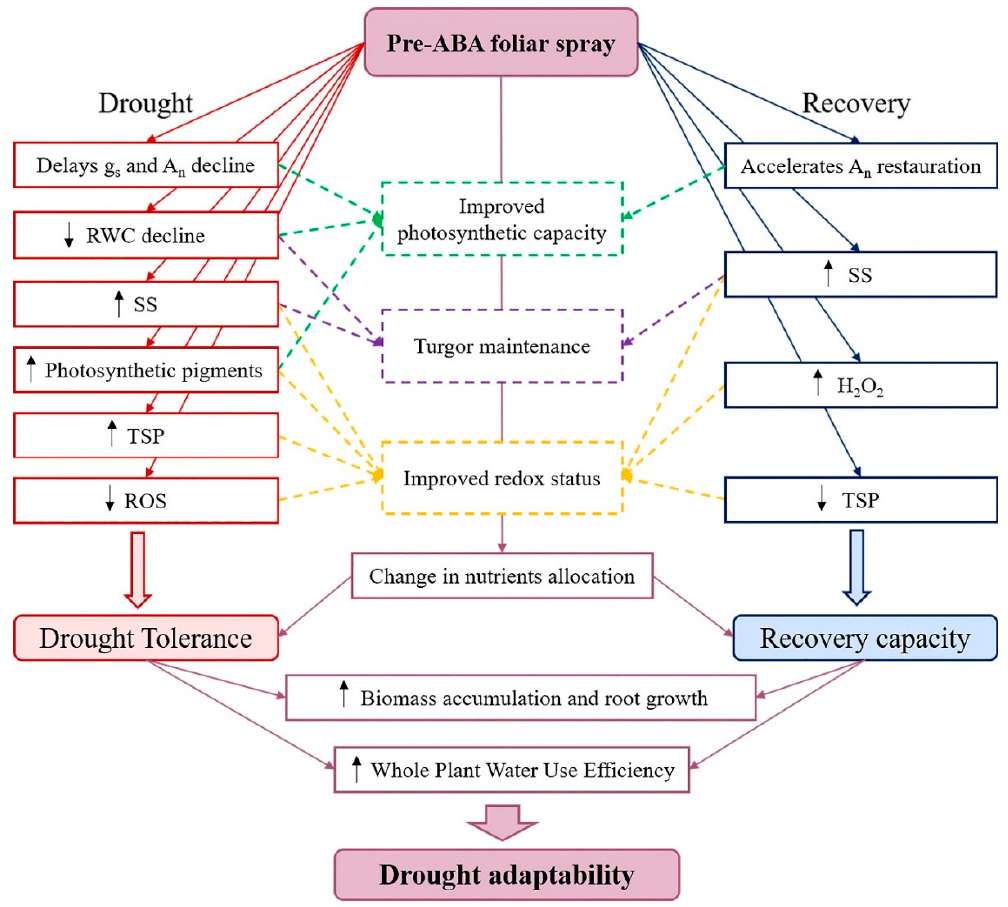
Figure 4. Abscisic acid-mediated responses of olive trees under drought and recovery events.